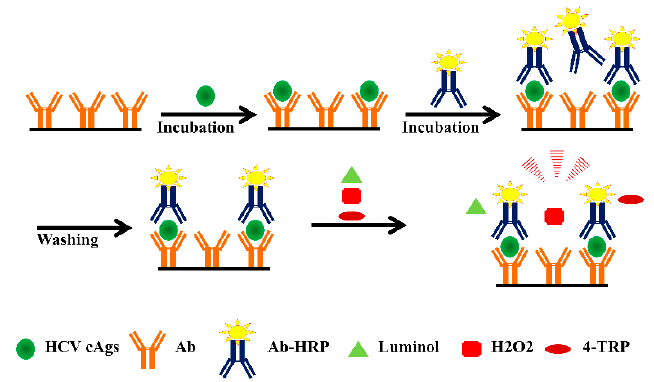
Figure 8. Schematic illustration of a CIA used for the detection of the HCV core antigen.